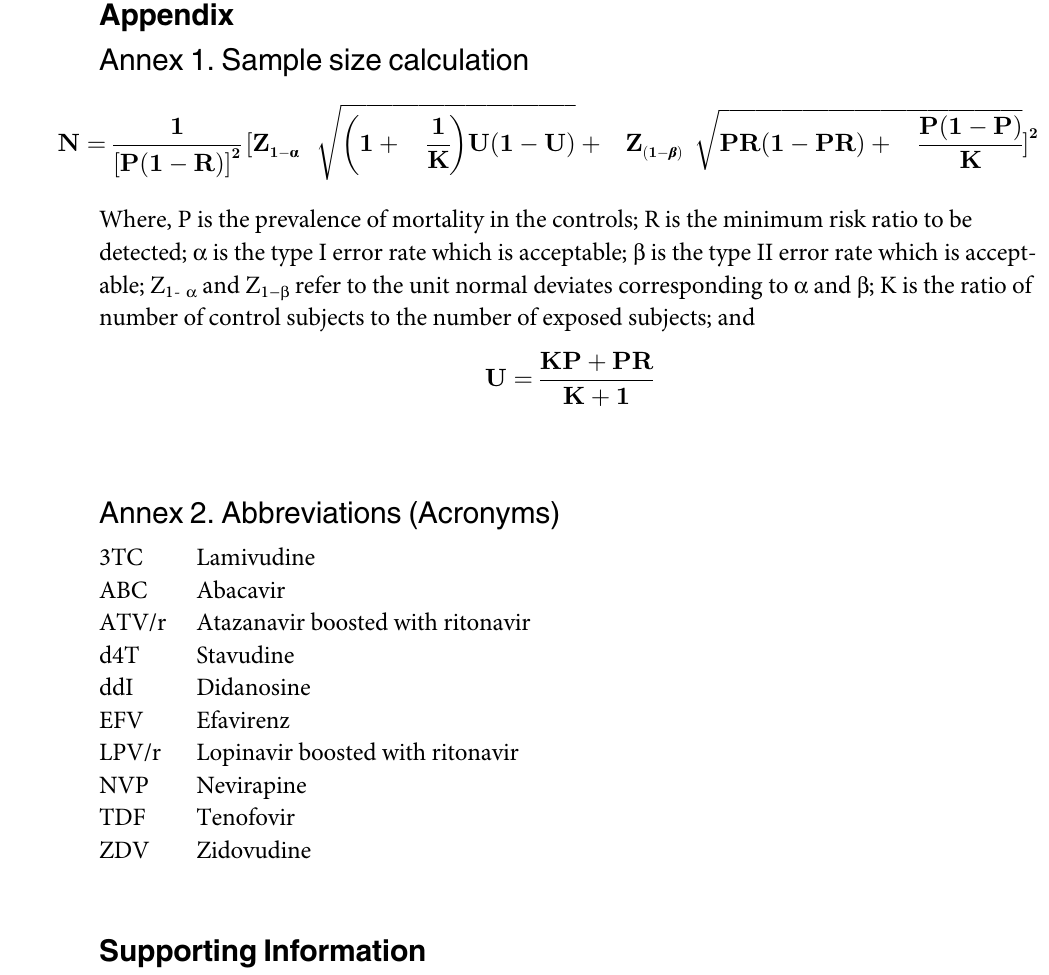
S1 Fig. Kaplan Meier survival curve among HIV patients with average follow-up CD4 < 350 cells/mm3 versus CD4 (cid:1) 350 cells/mm3 at TASH and ZMH, September 11,